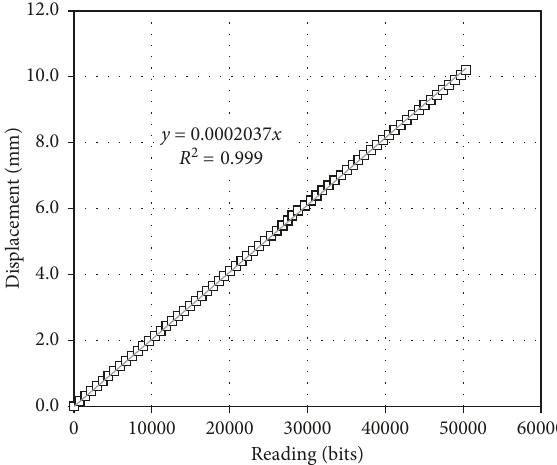
Figure 4: Calibration curve of radial